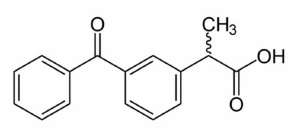
Figure 2. Ketoprofen structure.